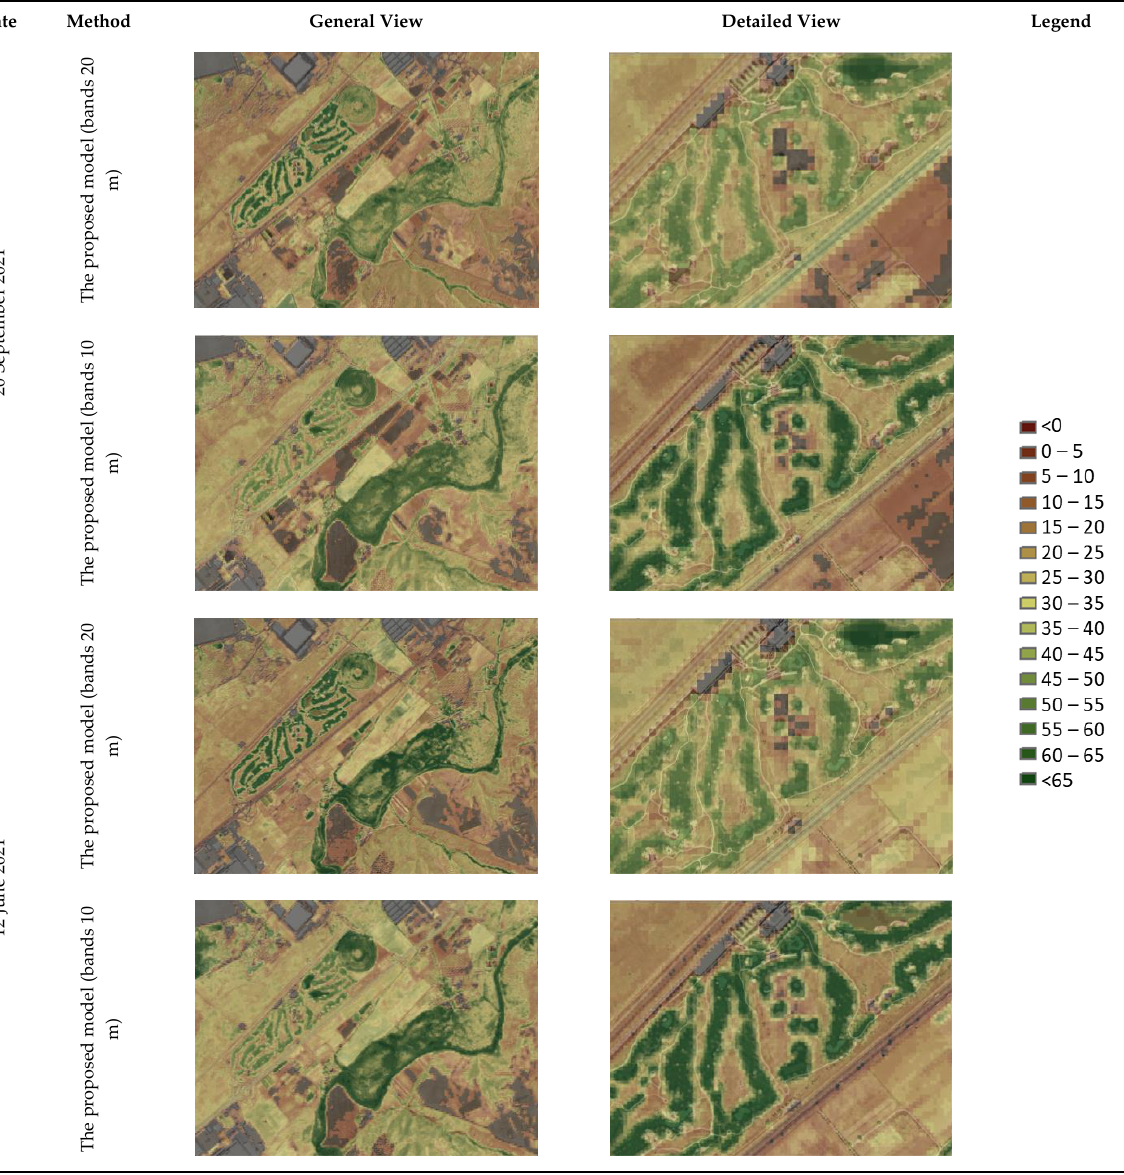
Figure 9. Comparison of proposed models. Models with transparency of 50% and Orthophoto of 2019. On the other hand, we perform a quantitative verification. For this verification, the soil moisture data of sensors from the clay soil of the golf course are compared with the results of generated models. In Figure 10a, we can see the six groups of data, which correspond to the 2 days and the 3 areas. In each data group, we can see in dark blu